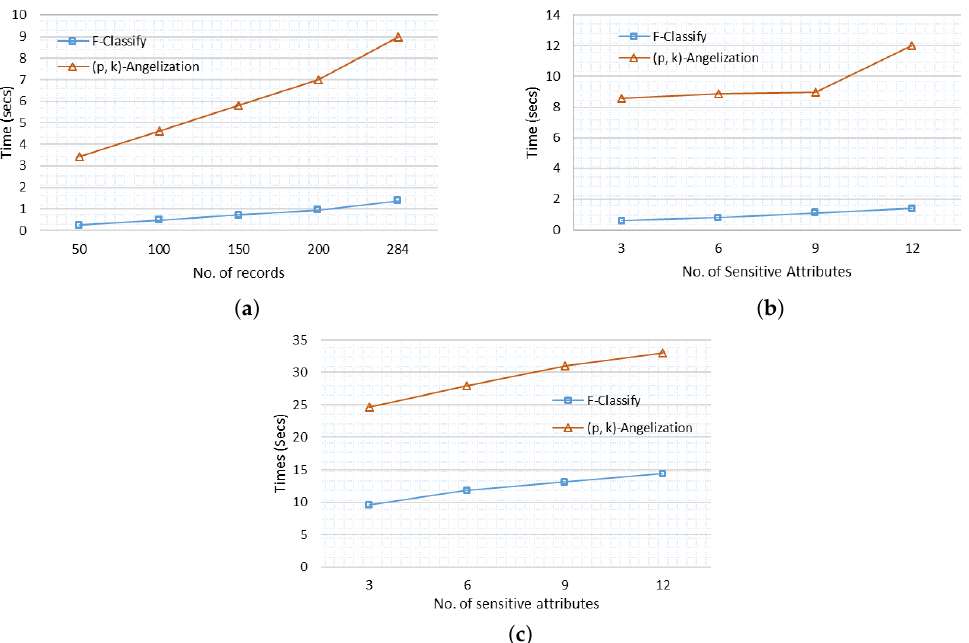
Figure 7. Execution time. ( a ) Execution time with increasing number of records (Heart Disease). ( b ) Execution time with varying number of sensitive attributes (Heart Disease). ( c ) Execution time with varying number of sensitive attributes